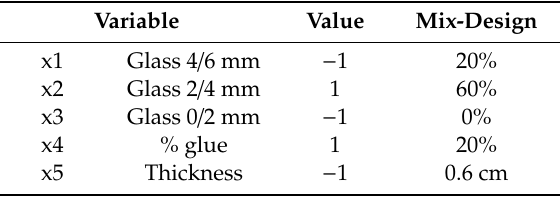
Table 7. Mix-design to minimize the power loss of the semi-transparent layer. Variable